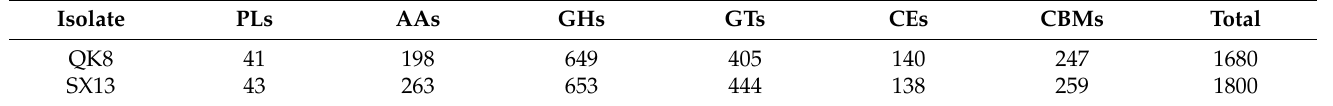
Table 4. Results of the CAZyme functional classification of strains QK8 and